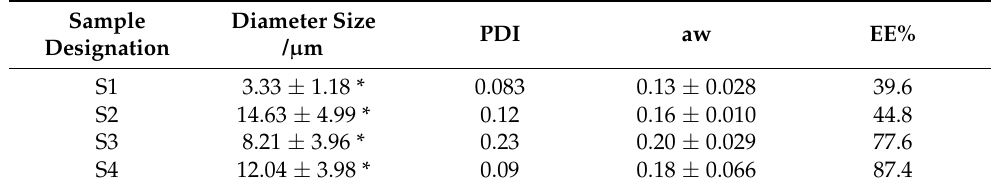
Table 2. Average diameter, water activity (aw), and encapsulation efficiency (EE) of the electrosprayed ETC core–shell microcapsules loading Bifido cells.